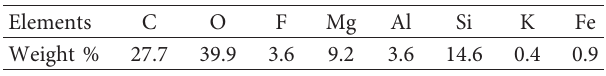
Table 4: Chemical elements of the Rh-CTAB in %.